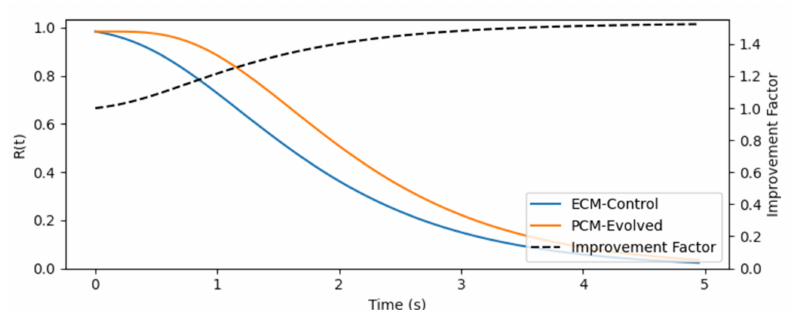
Figure 31. LSSE output for the Mean Task-Based Redundancy Function (MTBRF) and Reliability Improvement Factor of an experiment with 1000 MASs, with acceptable initial states, with 3 tasks and 5 agents in each